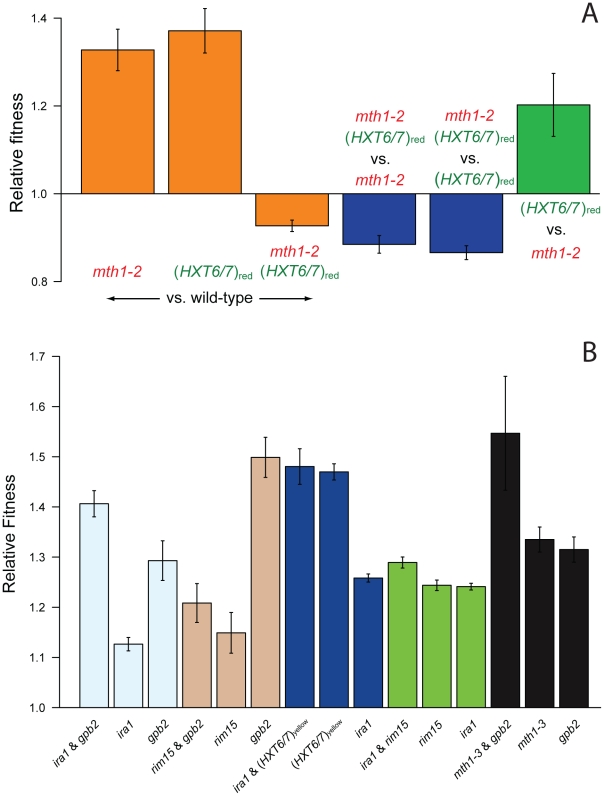
Competition experiments to test for epistasis between singly adaptive mutations.(A) Reciprocal sign epistasis between the mth1-2 and HXT6/7 amplification mutations from the red subpopulation, which results in a two-peaked fitness landscape (Figure S5); the mth1-3 and HXT6/7 amplification mutations from the yellow subpopulation give similar results (Figure S4). (B) Tests for epistasis between other singly adaptive mutations show pervasive negative epistasis between the pairs IRA1/(HXT6/7)yellow, IRA1/RIM15, MTH1/GPB2, as well as sign epistasis between RIM15 and GPB2. Sign epistasis would constrain the fitness landscape but would not lead to two fitness peaks. Error bars are 95% confidence intervals.